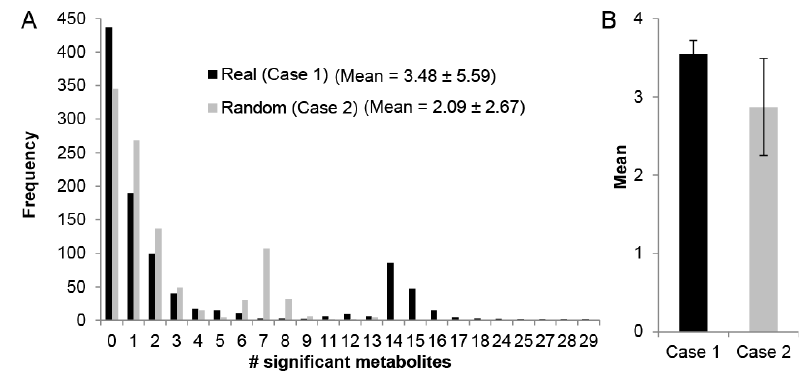
Figure 1. ( A ) significant metabolite distribution for N = 1000 randomly selected connected sub-graphs of 10 reaction nodes for the case where real metabolomics data for Liver 1 were used to determine significant metabolites by comparing metabolite levels between t = 0 to t = 3 h (Case 1) and where each of the 155 measured metabolites were randomly assigned significance with probability 73/155 (Case 2); ( B ) the distributions in ( A ) were obtained N = 25 times, and the mean of the distribution means were